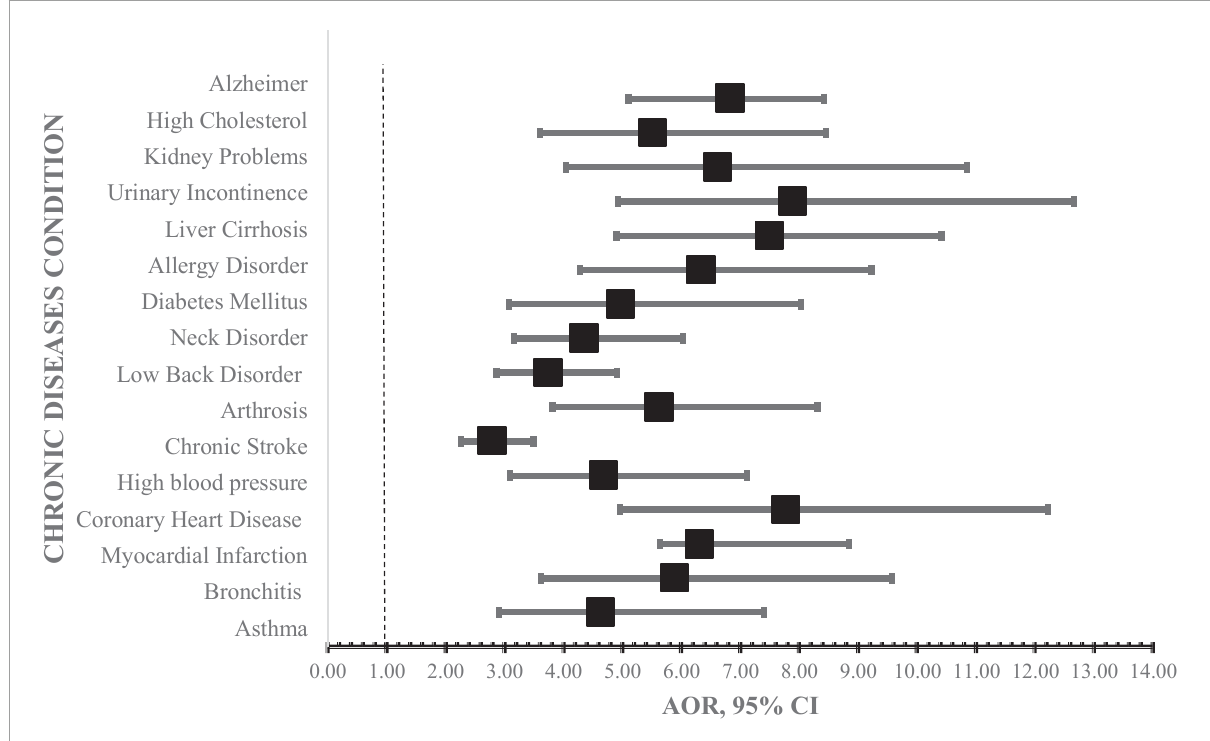
FIGURE2 Multivariate regression models for history of chronic diseases. AOR, adjusted odds ratio; 95% CI, 95% confidence interval. Model adjusted for individual level factors (gender, employment status, physical activity, general health status).